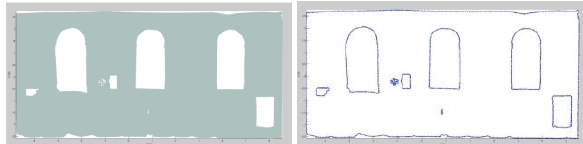
Figure 12. Contours extraction of a 3D column depending on the view direction; a) point cloud; b) rolled out as a plane and compared to its primitive (in meters) ; c) extracted contours regarding the view direction ( ds = 7 cm).